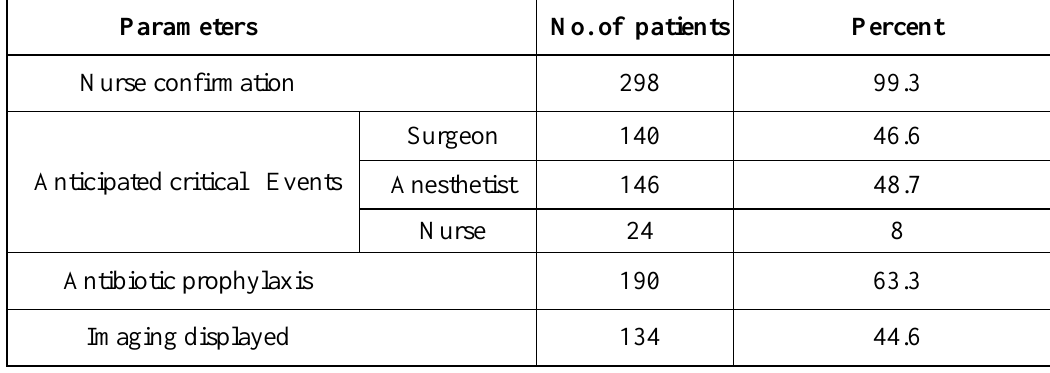
Table (2): Number of patients checked before skin incision (N=300)